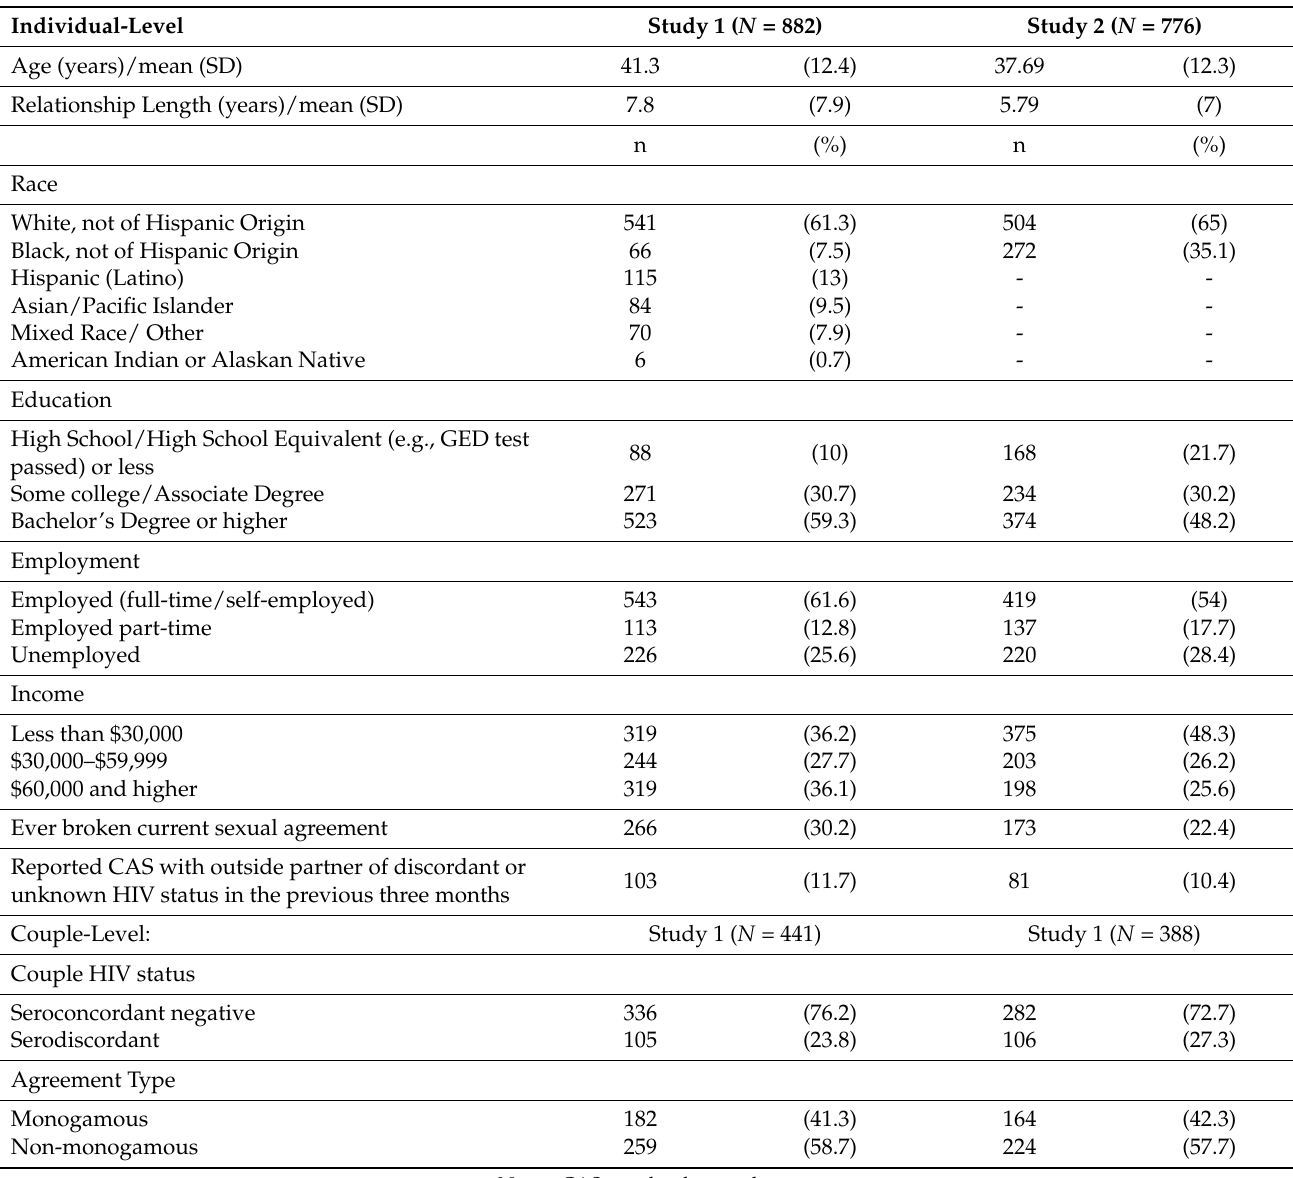
Table 2. Descriptive characteristics of study